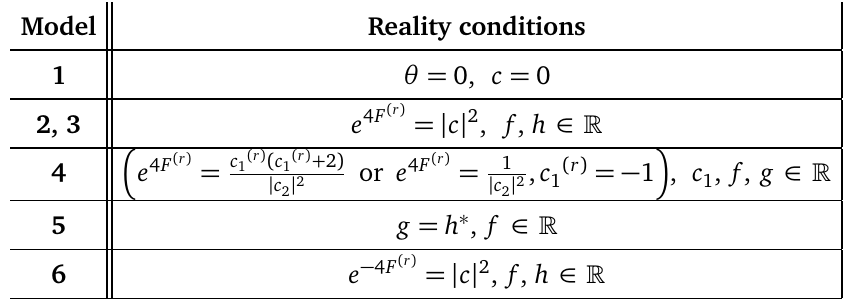
Table 5: Conditions on models 1-6 to make them Hermitian. We put the superscript ( r ) to identify the real part of the functions and constants.